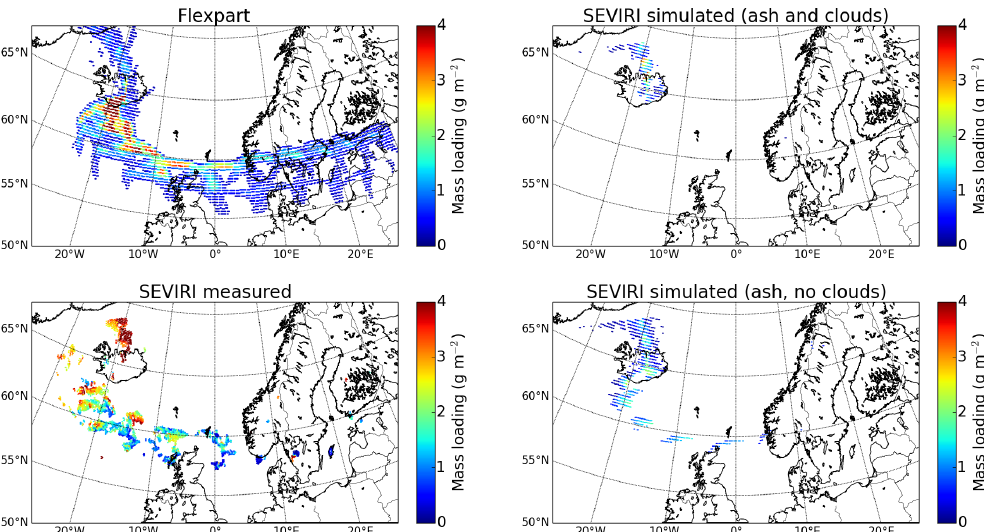
Figure 12. Modelled and retrieved ash-mass loadings for the Grímsvötn (2011) eruption between 21–27 May 2011 shown as mosaics of 6 hourly fields. (upper left) Flexpart model simulation, (lower left) retrieved from measured SEVIRI images, (upper right) retrieved from simulated cloudy SEVIRI images, (lower right) retrieved from simulated cloudless SEVIRI images. Note that composites of all individual 6-hourly scenes were constructed by taking for each pixel the maximum value of all scenes. For the measured SEVIRI data (lower left), all pixels with longitude > 10 ◦ W for the 22nd and 23rd , and for all subsequent days pixels with latitude > 63 ◦ N or longitude > 25 ◦ W or longitude > 30 ◦ E have been removed, as they are considered false positives.